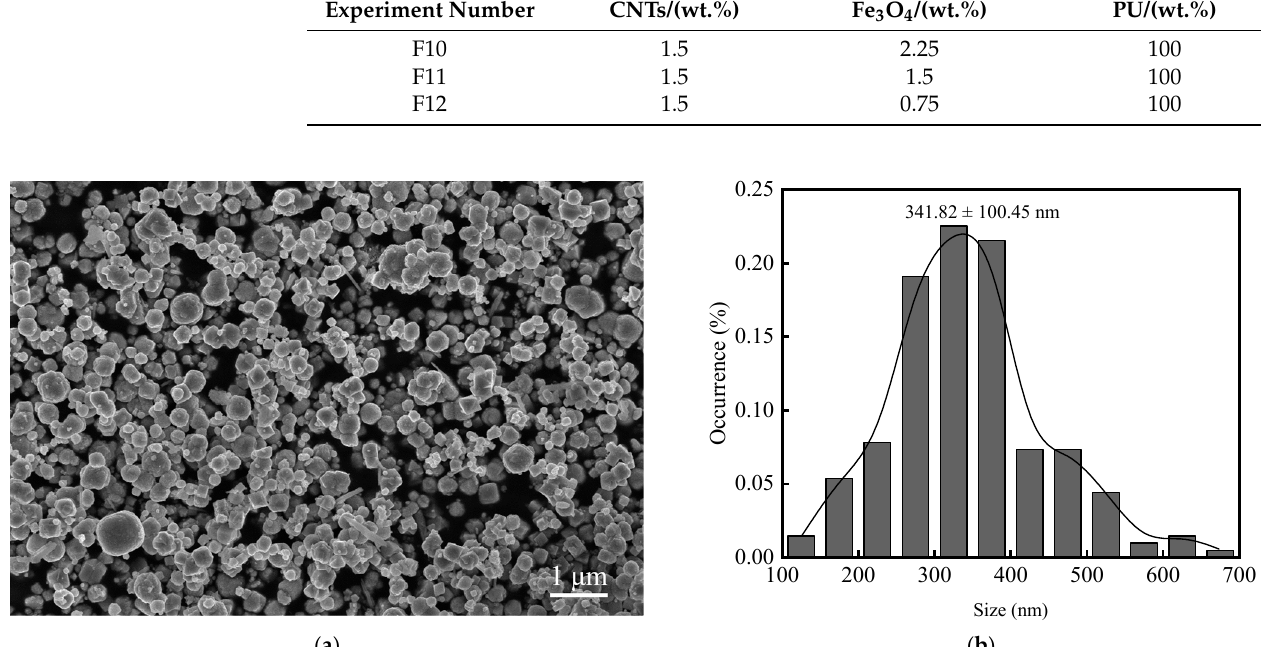
Figure 9. The SEM micrograph and particle size distribution of Fe 3 O 4 powders ( a ) SEM image (WD=9.2 mm, EHT=5.0 kV); ( b ) particle size distribution. Table 4. Experimental scheme for the ratio of Fe 3 O 4 /CNTs.